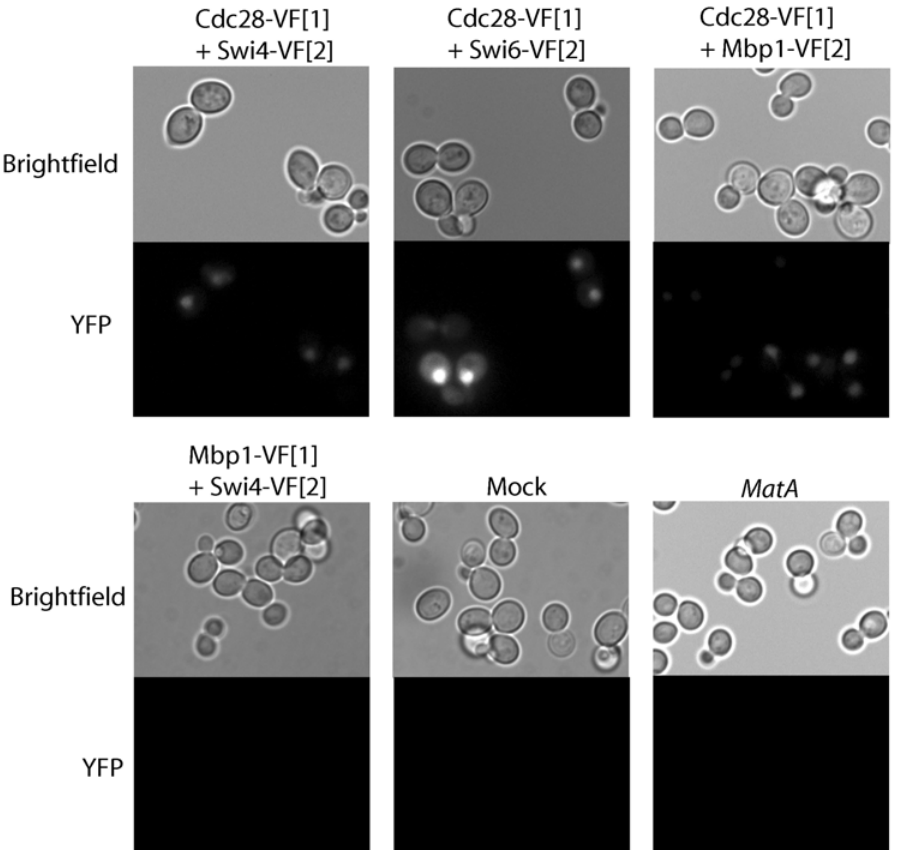
Figure 2. Interactions between Cdc28 and the components of SBF and MBF. Representative images of wild-type yeast transformed with the Cdc28- Swi4, Cdc28-Swi6 and Cdc28-Mbp1 yeast enhanced monomeric Venus (yEmVenus) PCAs. Fluorescence is detected in the nucleus for all three interactions. No fluorescence is detected in cells transformed with the negative control PCA Swi4-Mbp1, mock cells transformed with empty plasmids, or untransformed MatA cells.